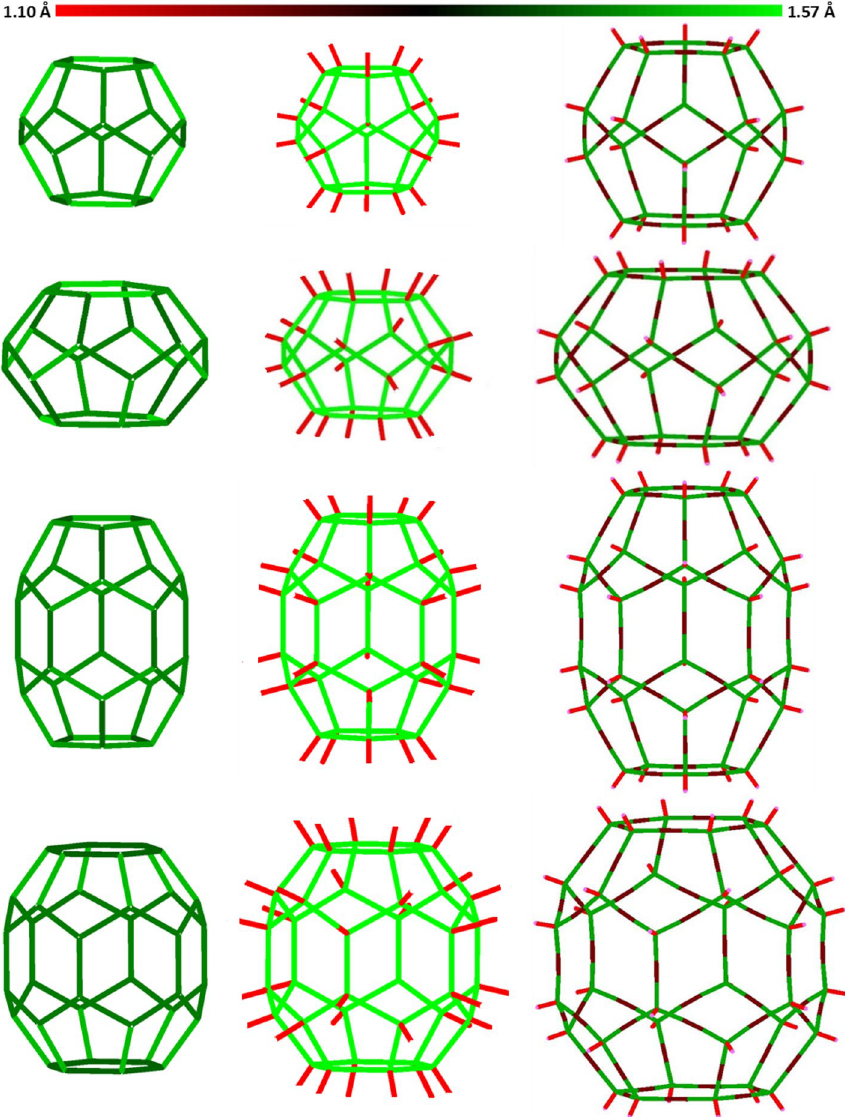
, which corresponds to , related Å Å